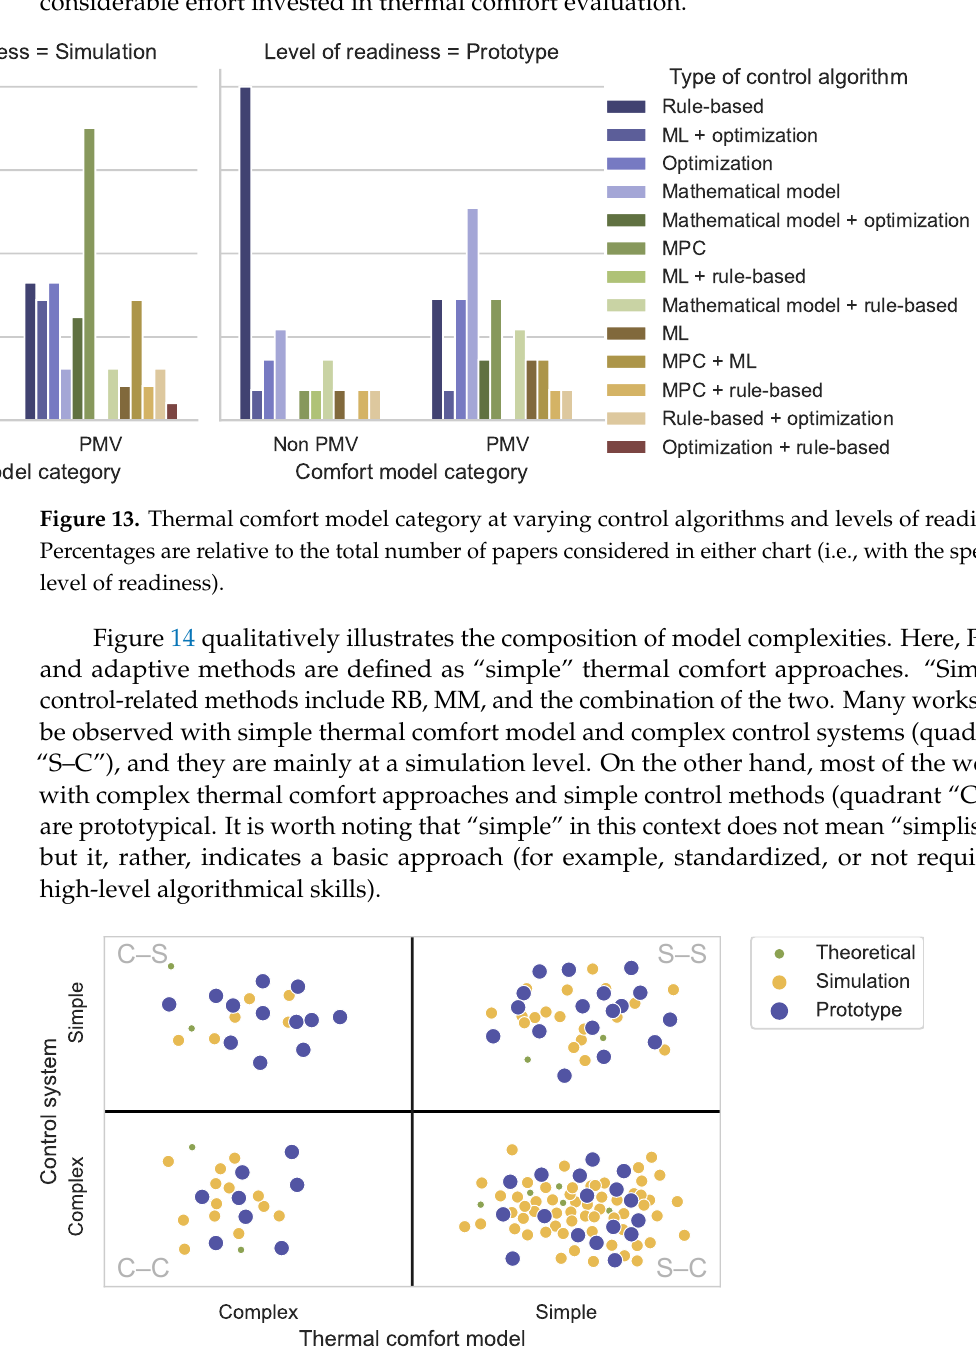
Figure 14. Qualitative illustration of thermal comfort model and control system complexities in the analyzed papers. The distribution of points within quadrants is